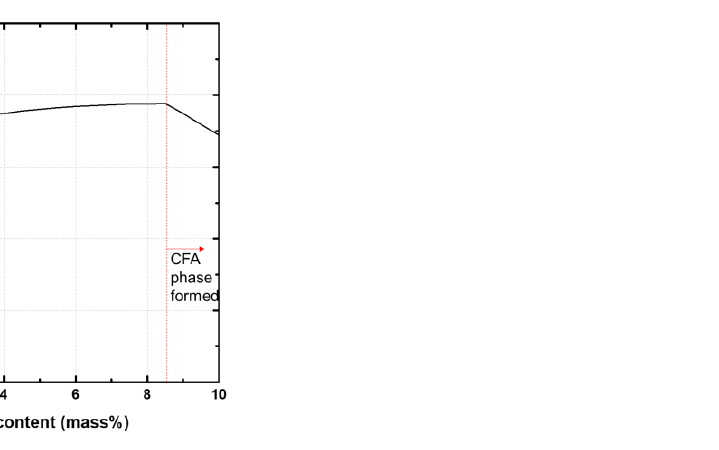
Figure 8. Variation of the liquid phase fraction with the Al 2 O 3 added in the Fe 2 O 3 -CaO-SiO 2 -Al 2 O 3 system (with 10 mass% CaO and 5 mass% SiO 2 ) in the equilibrium state calculated by Factsage 8.0.